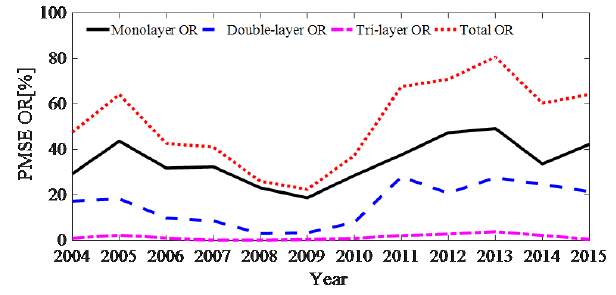
Figure 2. Annual mean layered PMSE occurrence ratio. The OR of the total (red dot line). The OR of the monolayer (black solid line). The OR of the double layer (blue dashed line). The OR of the tri-layer (pink dot–dashed line).